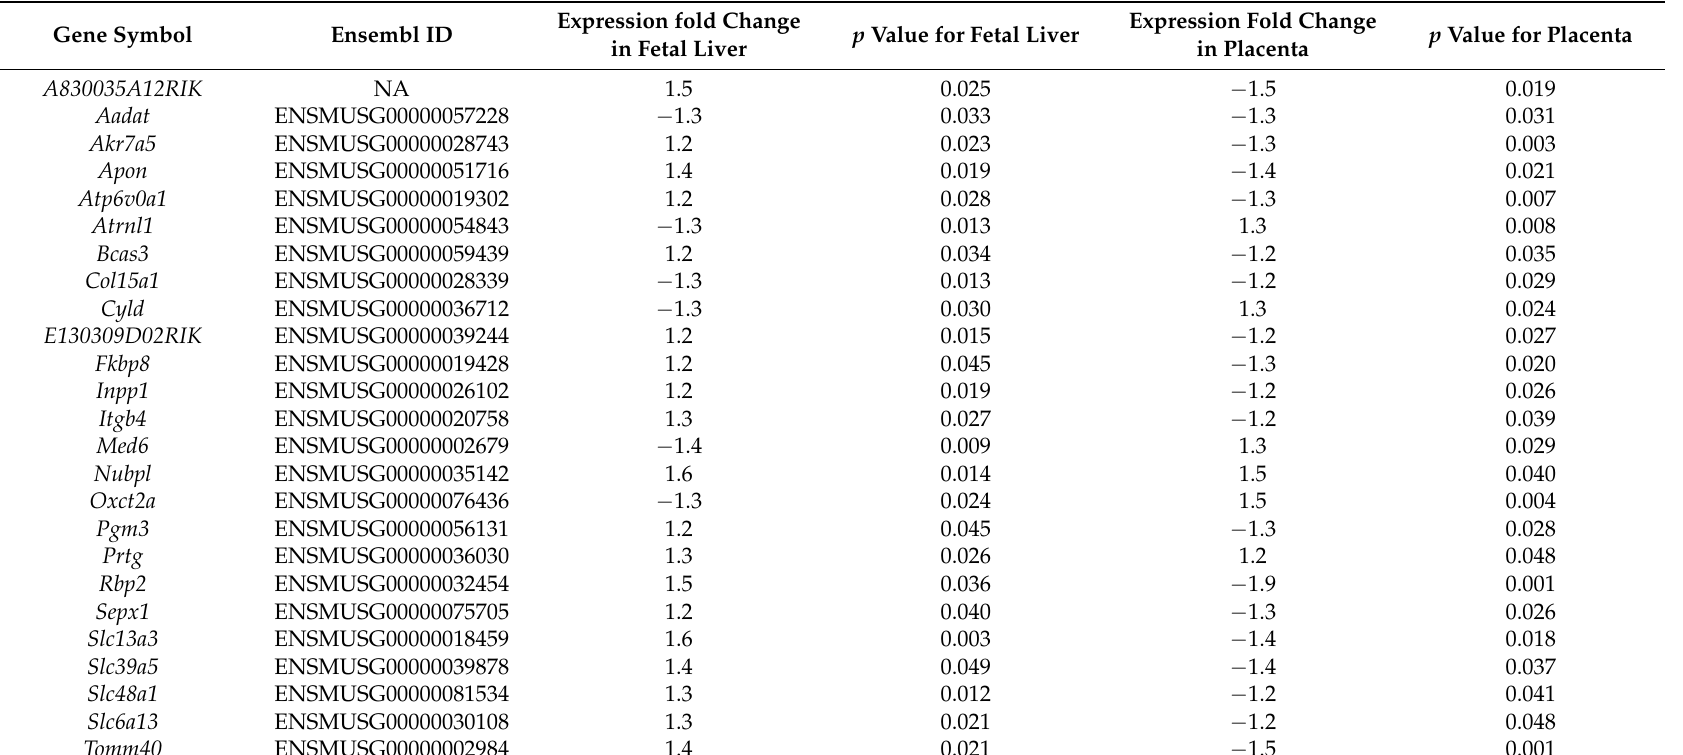
Table 7. Genes differentially expressed in both fetal liver and placental organs in response to maternal folate depletion 1,2,3